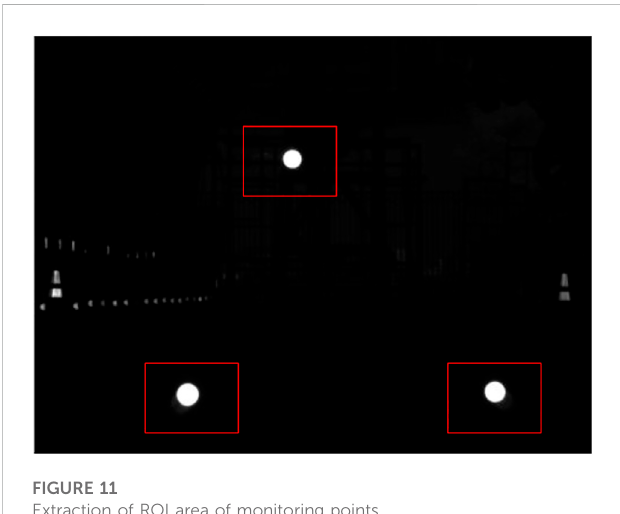
FIGURE 11 Extraction of ROI area of monitoring